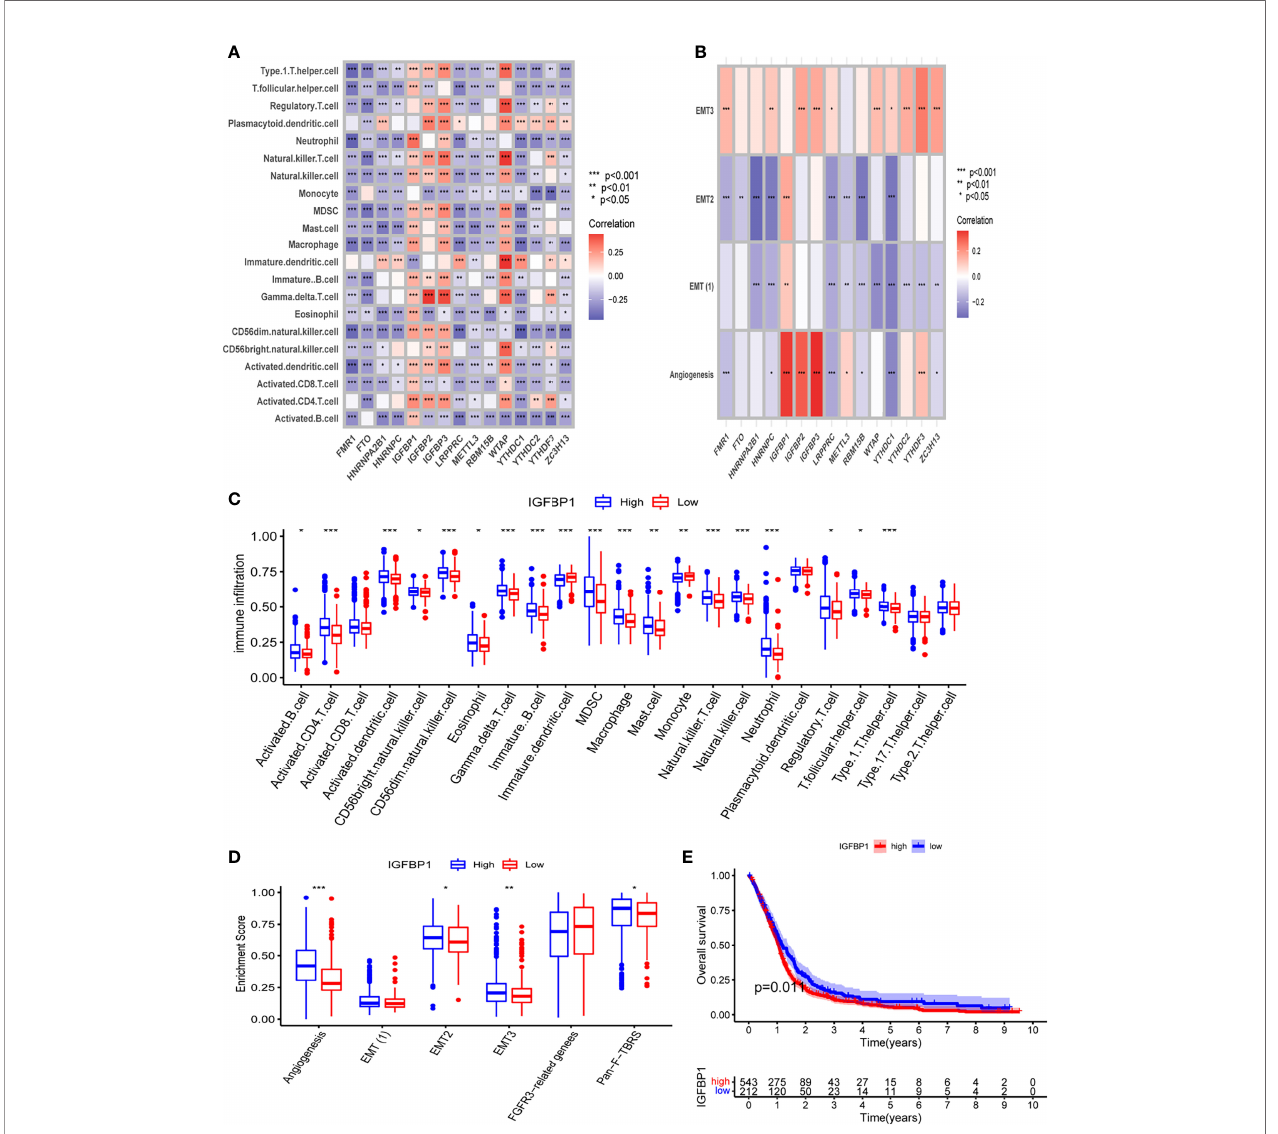
FIGURE 2 | The relationship between TME and m6A regulators. (A) The correlation between m6A regulators and in fi ltrated immune cells of TME. (B) The correlation between m6A regulators and stromal of TME. (C) Differential analysis of immune cell in fi ltration in high and low IGFBP1 expression groups. (D) Differential analysis of stromal-related pathway in high and low IGFBP1 expression groups. (E) K-M analysis between high and low IGFBP1 expression groups. *, **, and *** indicate p = < 0.05, < 0.01, and < 0.001,